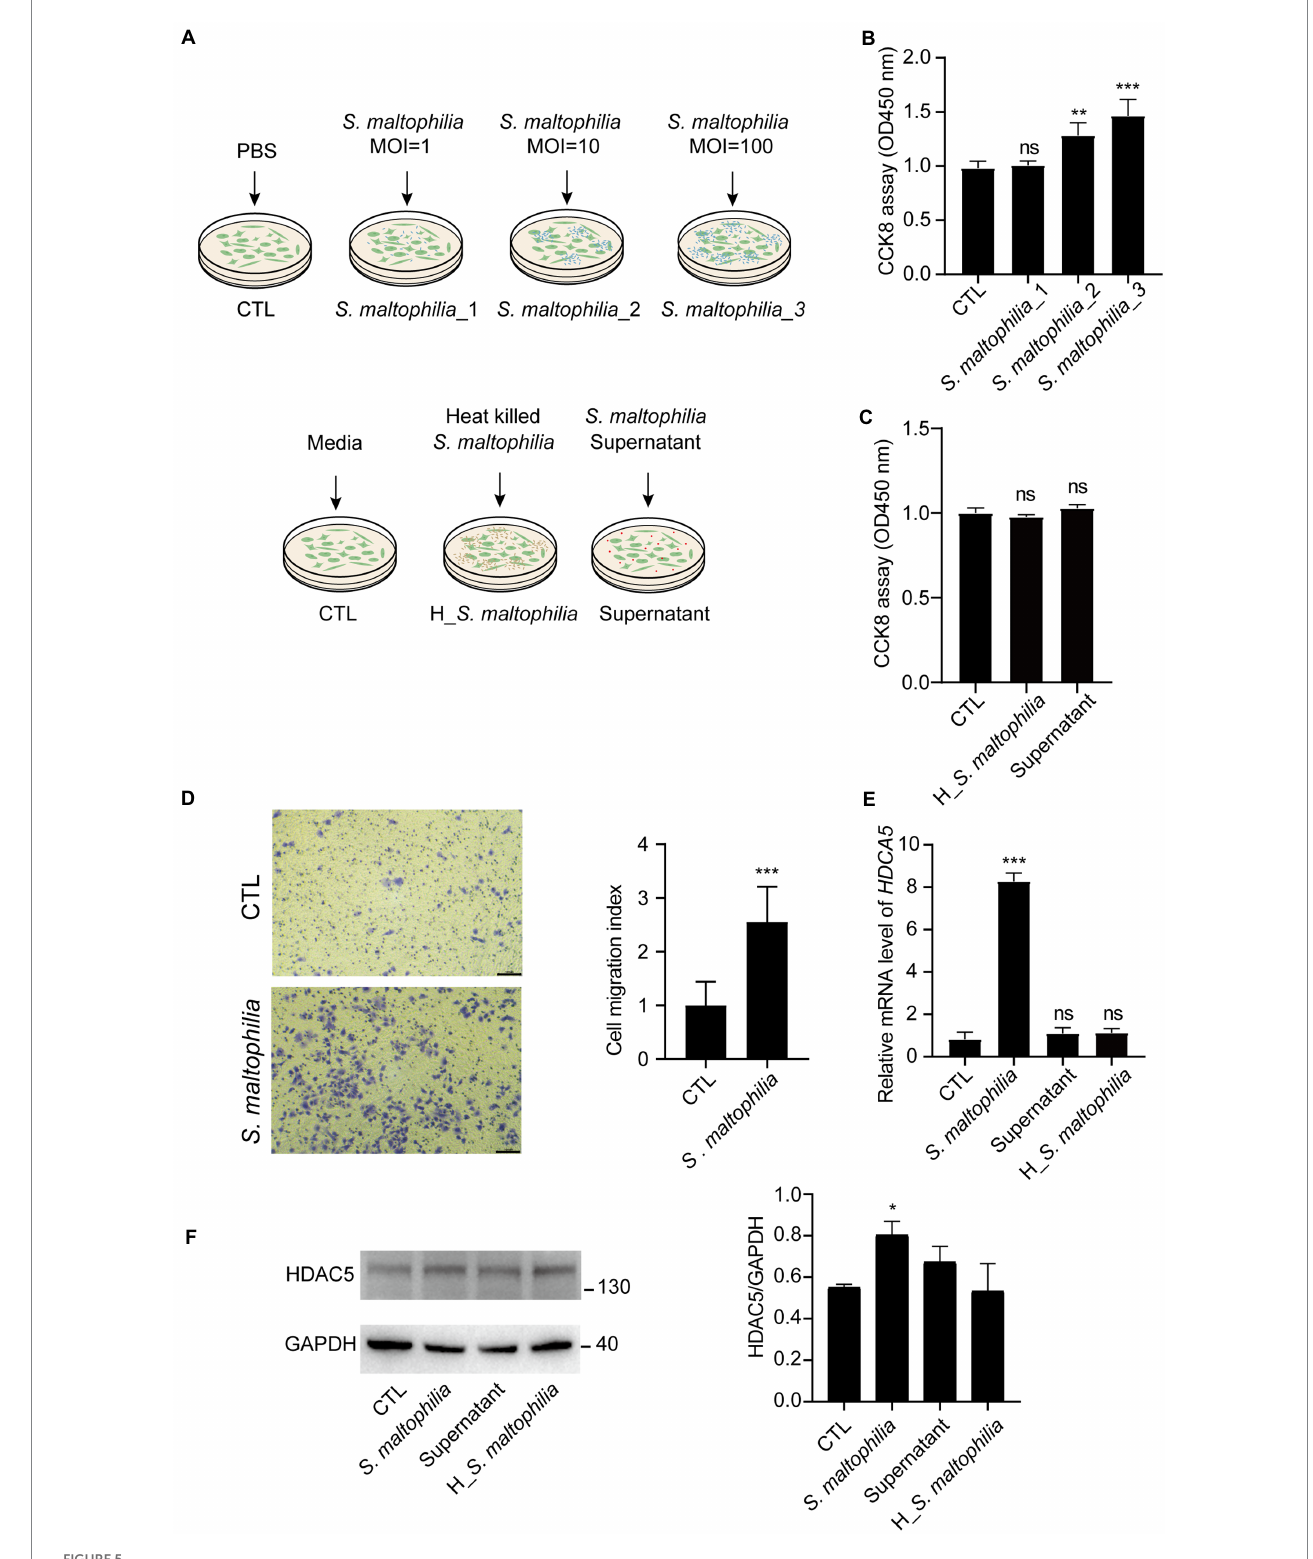
FIGURE 5 Stenotrophomonas maltophilia promoted cell and migration in lung epithelial cells. (A) Schematic experimental design for two in vitro experiments. For all conditions, A549 cells were exposed for 4 h and then harvested for RNA isolation. Experiment 1: Cells were infected with S . maltophilia (ATCC #13637) at three different multiplicity of infection (MOI) of 1, 10, and 100 for 4 h. Experiment 2: exposure to media alone, S . maltophilia (heat-killed), and supernatant. (B) Effect of S . maltophilia on A549 cell viability. (C) Effect of heat-killed S . maltophilia and supernatant on A549 cell viability, ns: no significance. (D) Effects of S . maltophilia on A549 cell line migration. (E) Effects of S . maltophilia on HDAC5 gene expression in A549 cells. ** p < 0.01 compared with CTL, *** p < 0.001 compared with CTL. (F) Western blot and statistical analysis of HDAC5 expression in A549 cells. * p < 0.05. ns, no